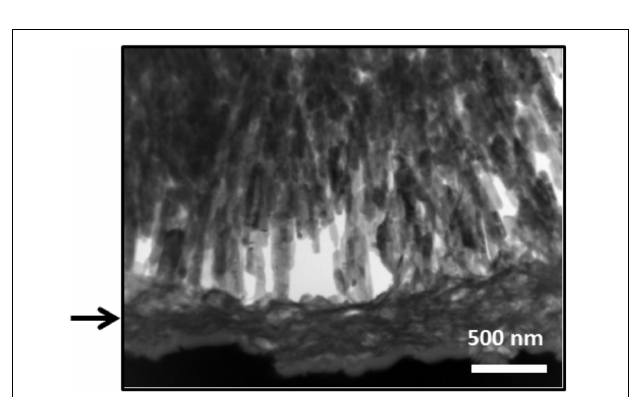
FIGURE 8 | Transmission electron microscopy images of the FIB cross-section. The collagen fibers covered the aragonite needles. Crystal surface with organic fibers covering the calcium carbonate crystal. Arrow indicated the localization of collagen